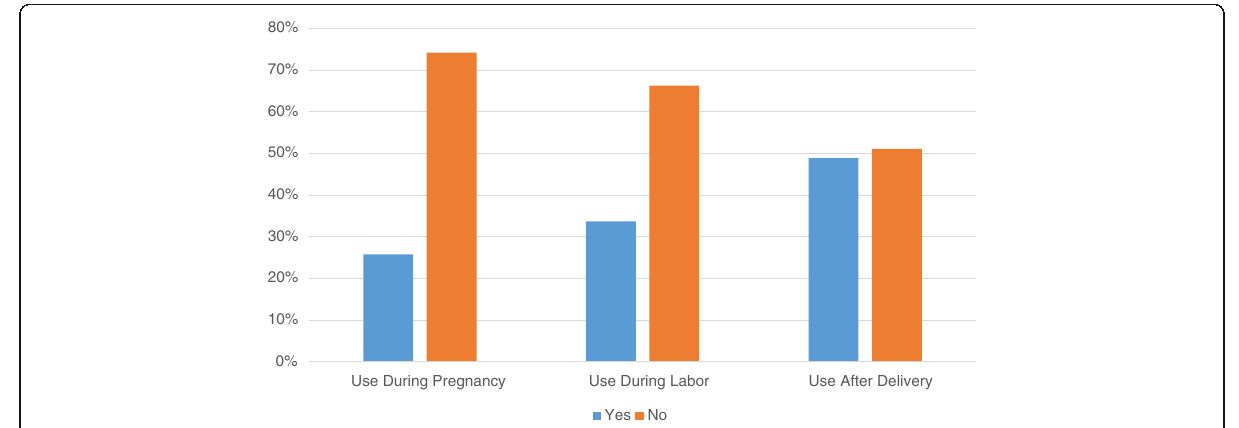
Fig. 2 Prevalence of herbal medicine use during pregnancy, during labor and after